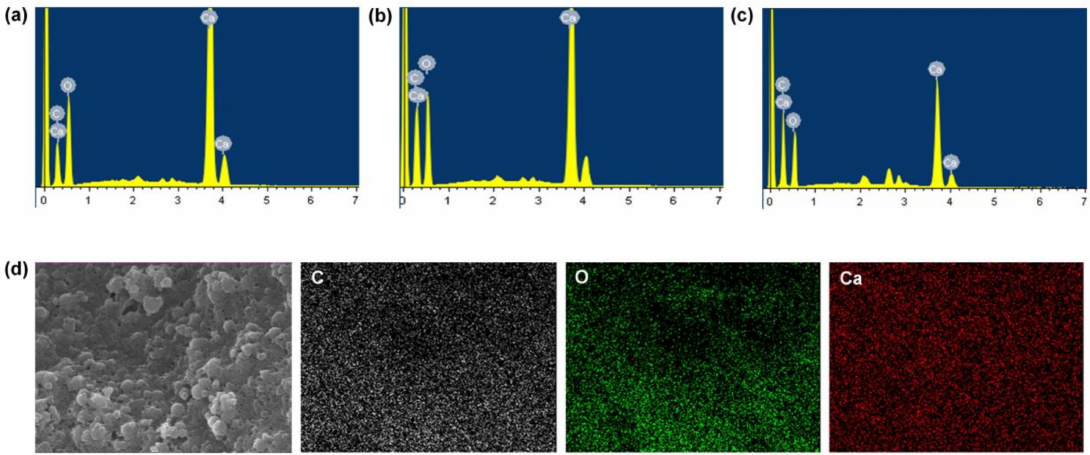
Figure 3. SEM-EDS results of ( a ) TA (10 mg) / CaO 2 , ( b ) TA (25 mg) / CaO 2 , and ( c ) TA (50 mg) / CaO 2 . ( d ) SEM image and the corresponding EDS elemental maps of carbon (C; white), oxygen (O; green), and calcium (Ca; red) in TA (10 mg) / CaO 2 nanoparticles.